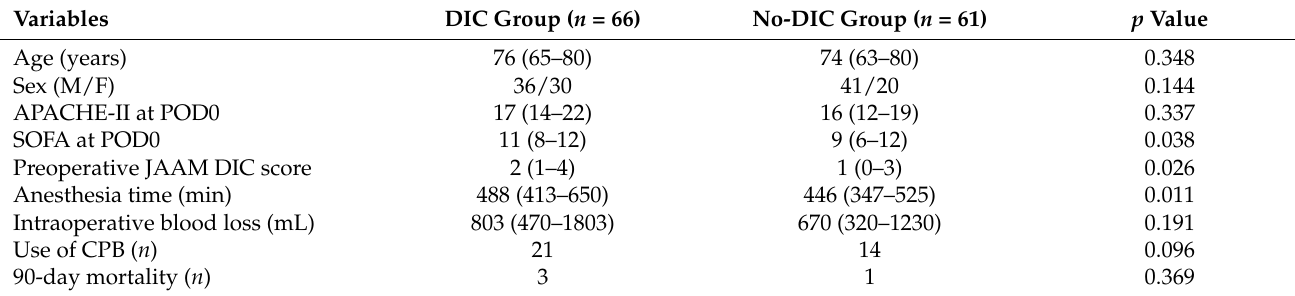
Table 5. Cardiovascular surgery-associated DIC at POD7.